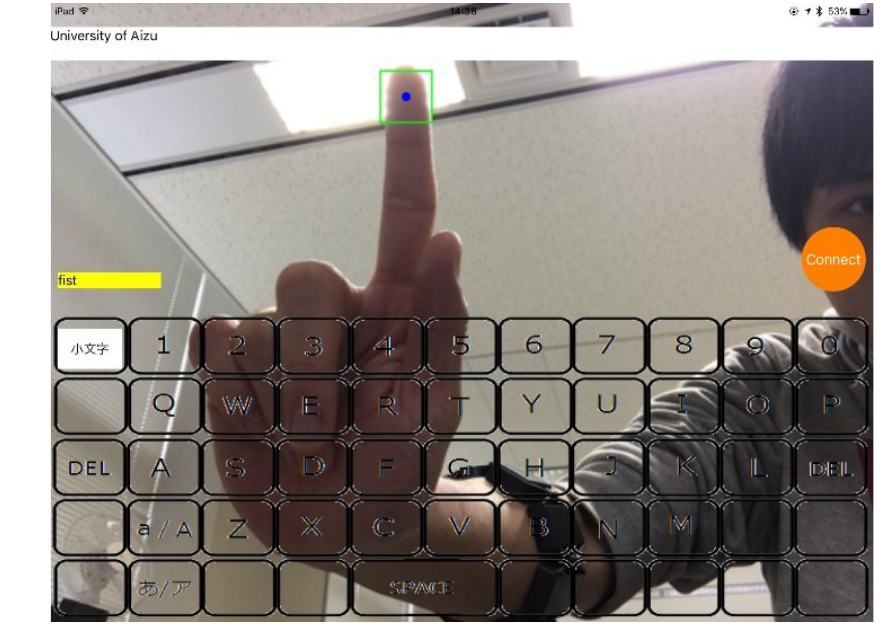
Figure 13. Simulation of a user’s performance.